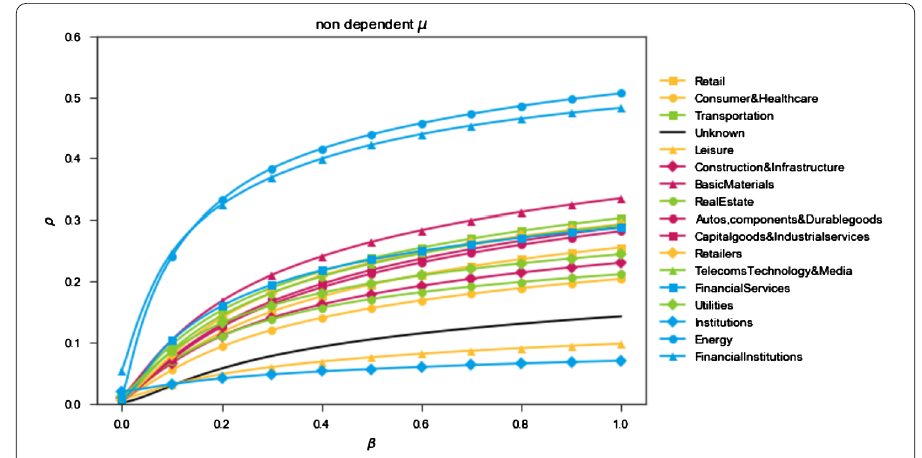
Figure 4 Sectoralrecoveryratedependenceofthefractionofinfectednodes . Sector ρ ( β , μ ) distribution when μ is